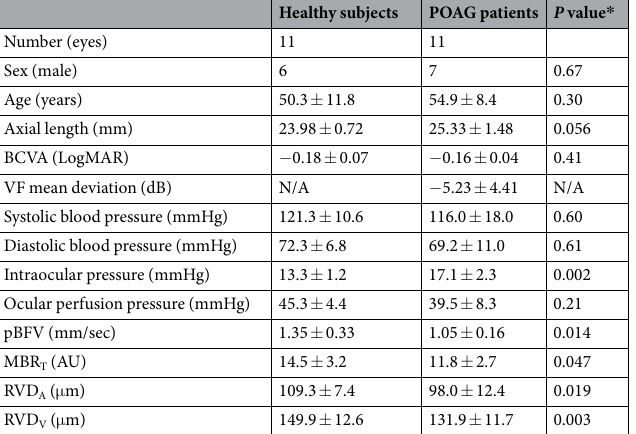
Table 1. Baseline Characteristics of Patients with Primary Open Angle Glaucoma and Healthy Subjects. Values comprise mean ± standard deviation. POAG = primary open-angle glaucoma; BCVA = best corrected visual acuity; LogMAR = logarithm of minimum angle of resolution; VF = visual field; pBFV = parafoveal retinal blood flow velocity; MBR T = mean blur rate in the tissue area of the optic nerve head; RVD A = retinal vessel diameter of artery; RVD V = retinal vessel diameter of vein; N/A = not applicable. * Comparison was performed using the chi-square test for sex and the unpaired t-test for the other parameters.